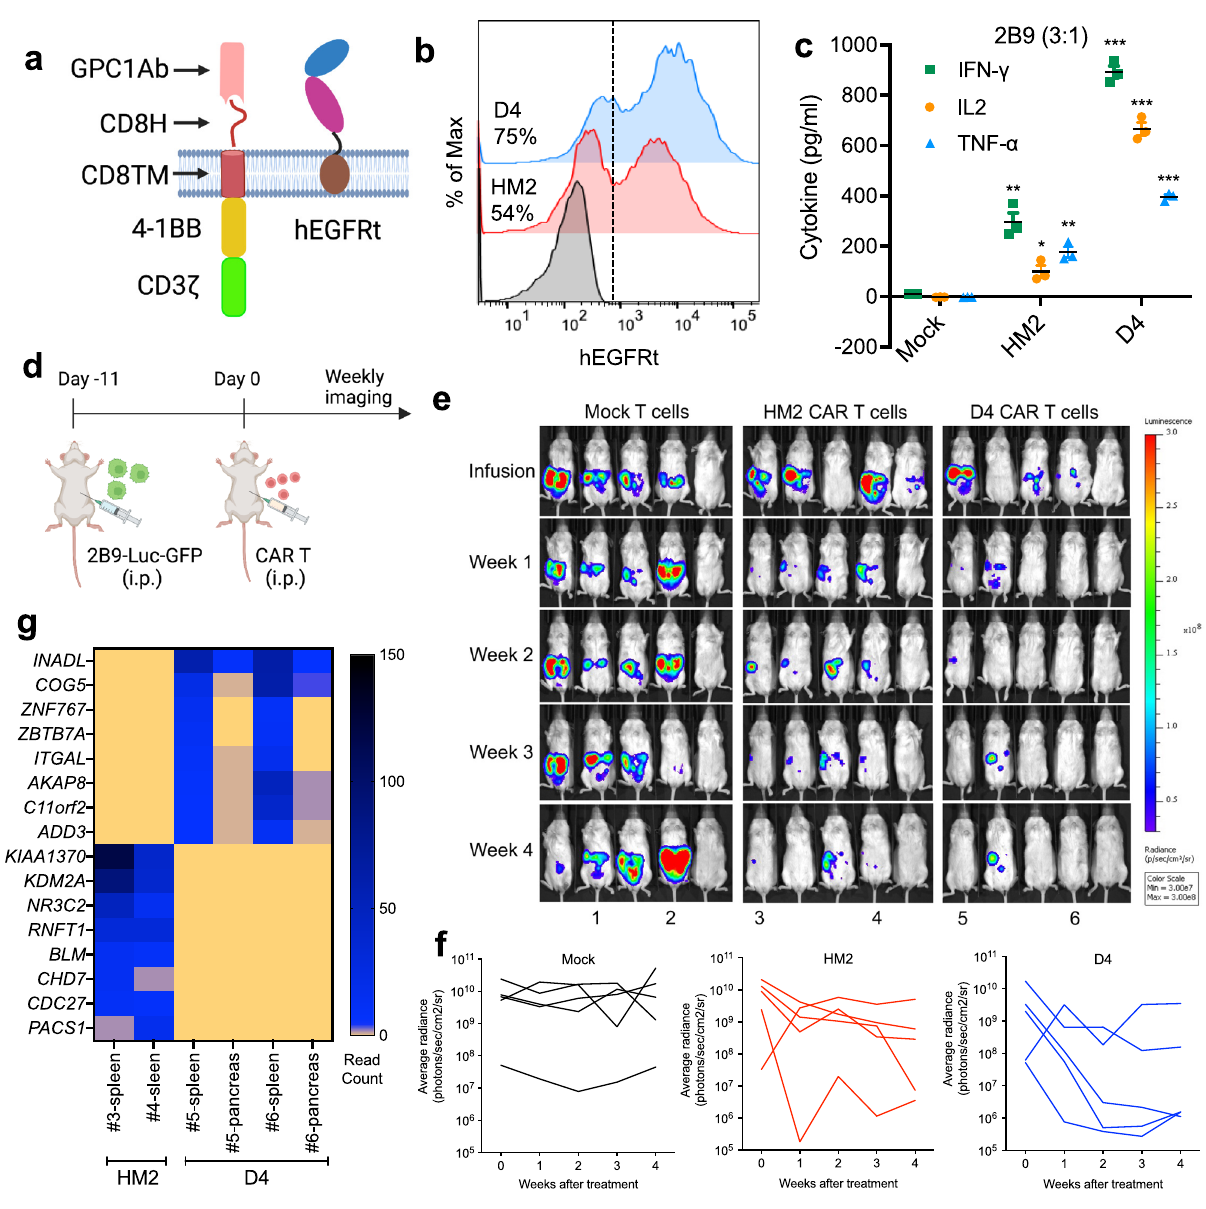
Fig. 2 | GPC1-targeted CAR T cells eradicate tumors in the 2B9 intraperitoneal dissemination xenograft mouse model. a Schematic of the GPC1-targeted CAR construct. The illustration wascreated with BioRender.com. b CARs expressionon Tcellswereanalyzedusing fl owcytometrybydetectionofhEGFRtexpression.Data are representative of two independent experiments. c The secretion of IFN- γ , IL-2 and TNF- α in the CAR T and 2B9 co-cultured supernatant at E:T ratio of 3:1. n =3 independent experiments. * p =0.011, ** p <0.01, *** p <0.001, two-tailed unpaired Student ’ s t test. d Experimentschematic(createdwithBioRender.com).2B9tumor-